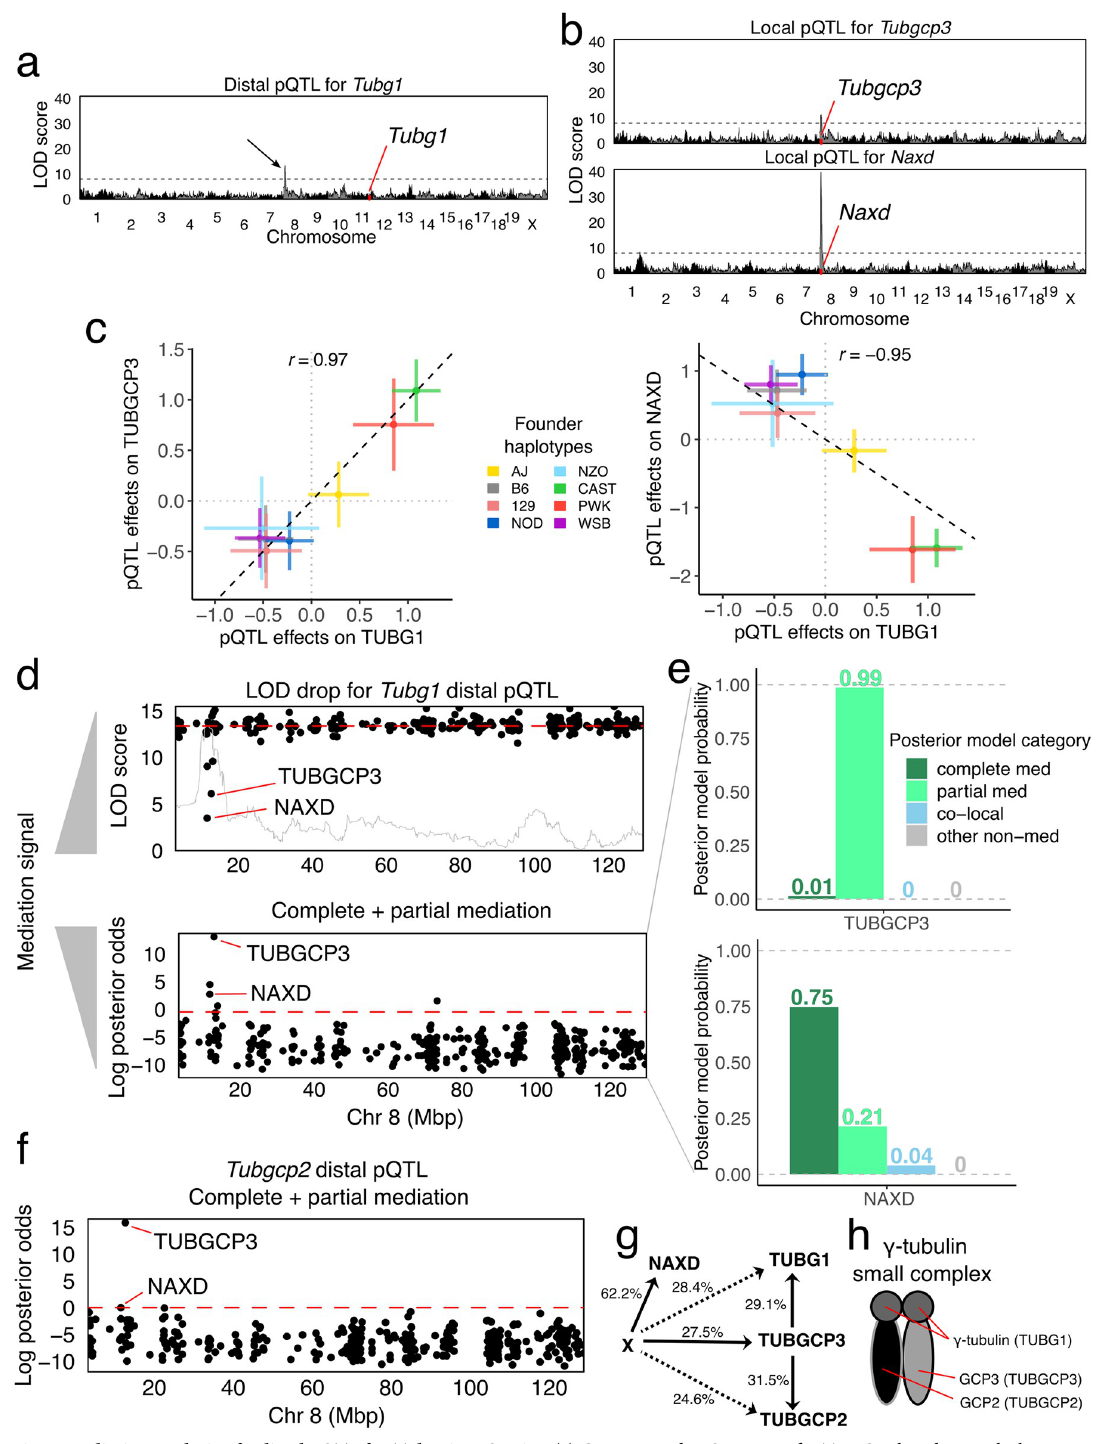
Fig 7. Mediation analysis of a distal pQTL for Tubg1 in DO mice. (a) Genome-wide LOD scores for TUBG1 abundance. Black arrow indicates distal pQTL on chromosome 8. (b) Genome-wide LOD scores for two genes, Tubgcp3 (top) and Naxd (bottom), with co- mapping local pQTL. (c) Comparison of the founder haplotype effects of the Tubg1 pQTL with Tubgcp3 (left) and Naxd (right) pQTL. (d) Mediation scans of all observed proteins on chromosome 8 by LOD drop with an overlay of the pQTL LOD scores in gray (top) and Bayesian model selection log posterior odds for mediation (bottom) show different prioritization for candidate mediators NAXD and TUBCP3. Note that low LOD drop scores indicate stronger mediation signal. (e) Posterior model probabilities for the Tubg1 distal pQTL